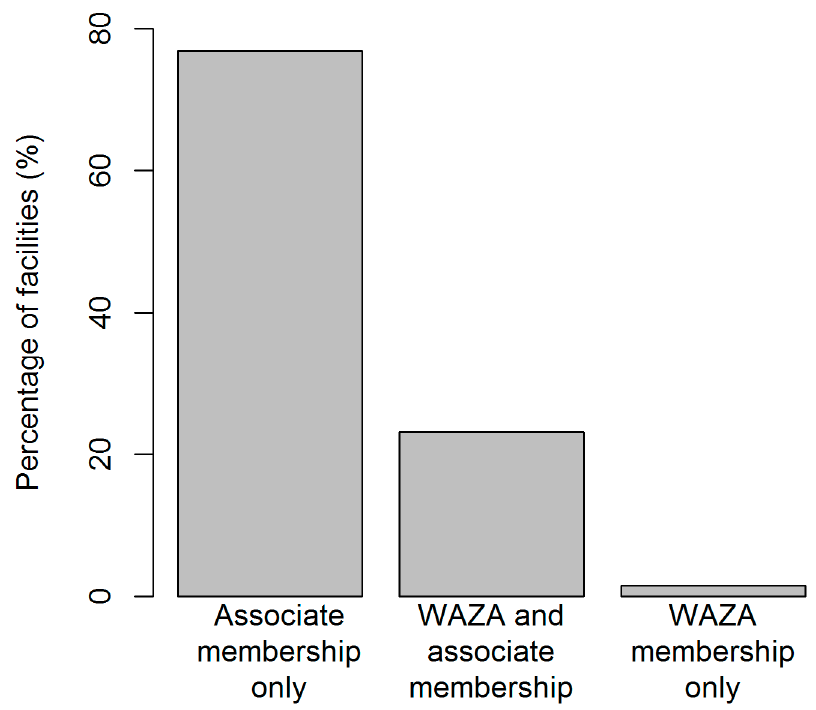
Figure 1. The number of facilities with a World Association for Zoos and Aquariums (WAZA) membership only, a WAZA and an association membership, and an association membership only.